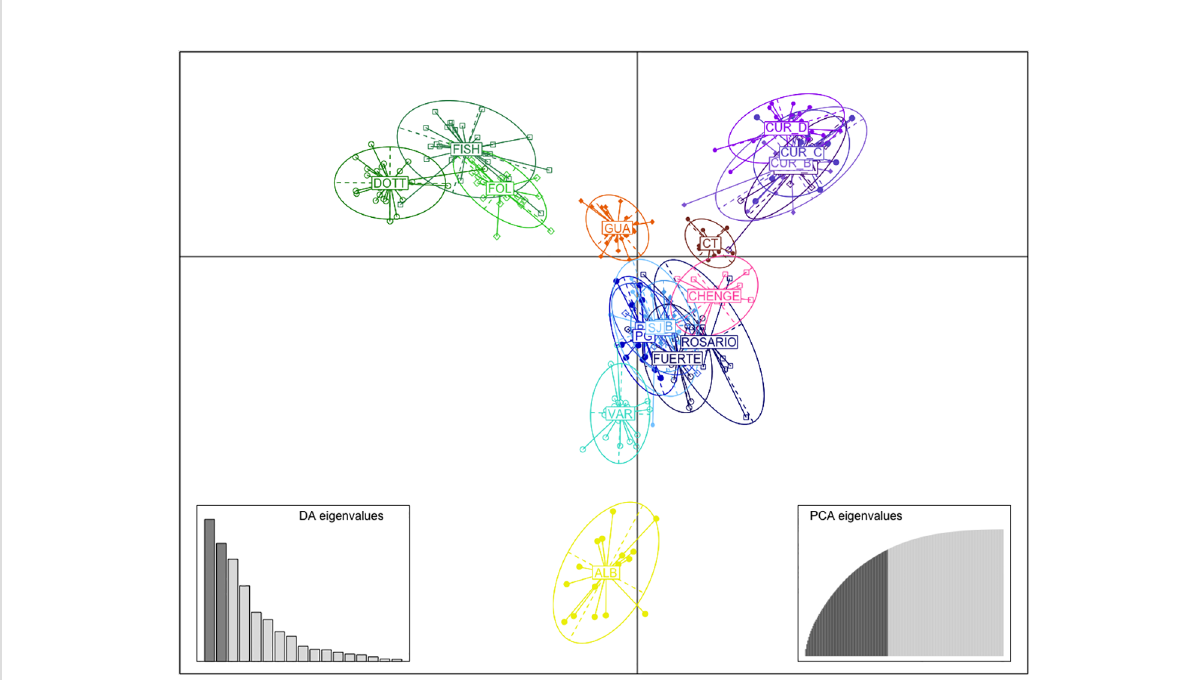
FIGURE 3 DAPC using the fi rst two principal components by localities; GUA, Guatemala, ALB, Albuquerque-Sea fl ower Reserve, CT, Cabo Tiburon, FUERTE, Isla Fuerte, ROSARIO, Corales del Rosario, BARU, Baru ́ , PB, Punta Bota, PG, Punta Gigante, SJ, Sr. Juan, VAR, Varadero, CHENGE,